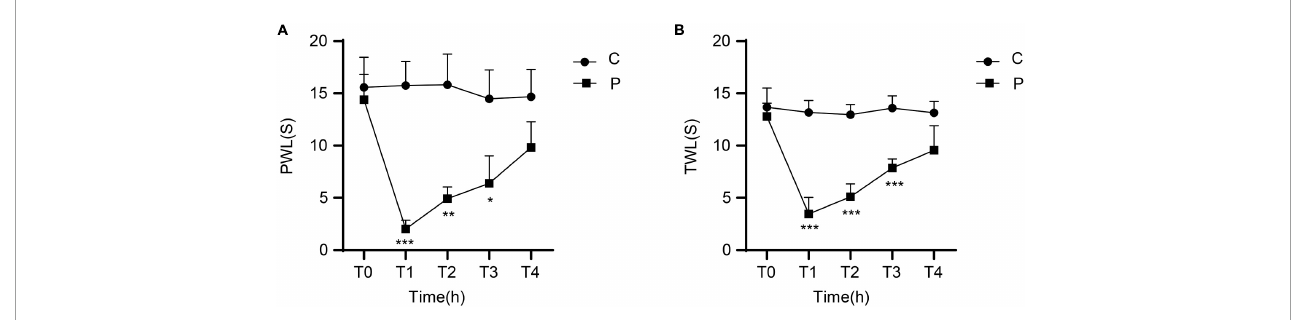
FIGURE1 Changes in mechanical withdrawal threshold (MWT) measured as paw withdrawal latency (PWL) and thermal withdrawal latency (TWL) of rats at different time points after incisional pain modeling (group P). n = 6 rats/group/time point. (A) MWT. (B) TWL. * P < 0.05, ** P < 0.01, and *** P < 0.001, P group vs. C